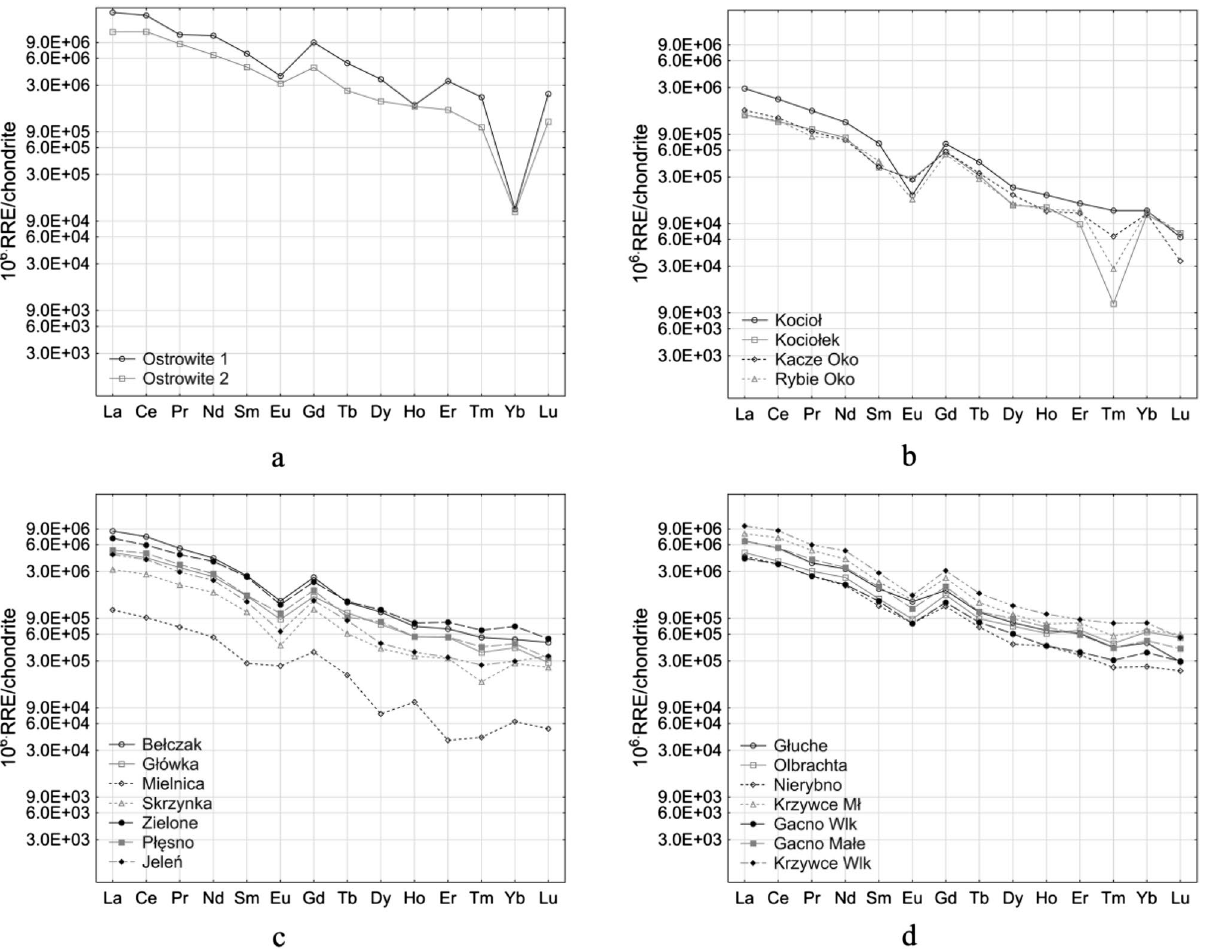
Figure 4. Standardized REE contents according to chondrite. Figure generated in Statistica 13. (https ://softw are.dell.com/produ cts/stati stica Rybie Oko lakes 0.30 and 0.42, respectively. A positive Gd anomaly was found for all lakes in the range from 1.28 to 1.71. Yb analysis showed a very strong negative anomaly for Ostrowite Lake (0.05 and 0.10) and a very strong positive anomaly for Kociołek, Kacze Oko and Rybie Oko lakes (from 2.34 to 2.76). In the case of Kociołek and Rybie Oko lakes there were negative Tm anomalies of 0.14 and 0.26, respectively. REE analysis in particular groups showed that LREE dominated over MREE and HREE in bottom sediments (Fig. 5). This is confirmed by earlier studies by Sojka et al. 32 , obtained for Lake Wadąg located in north-eastern Poland. Benabdelkader et al. 65 demonstrated that reservoirs play an important role in REE retention (LREE) and to delay the release of MREE and HREE downstream. There was slightly more MREE in the individual lakes than HREE. Only in the case of Kociołek, Kacze Oko and Rybie Oko lakes were the MREE and HREE contents at a similar level. The (La/Yb) N ratio normalized in relation to chondrite in the bottom sediments of the BTNP lakes ranged from 7.7 to 160.4. The lowest (La/Yb) N ratio was observed in Lake Olbrachta (7.7) and the highest in the western and eastern parts of Ostrowite Lake (160.4 and 103.7, respectively). In the other lakes the values (La/Yb) N ranged from 9.6 to 23.4. The obtained values were generally lower than that obtained by Sultan and Shazili 71 which was about 20.6. The CA analysis for TEs enabled the division of lakes into two main groups: TE-1 and TE-2 (Fig. 6a). Within each of the groups, two subgroups have been distinguished. The TE-1–1 subgroup includes western and eastern part of Ostrowite Lake with the highest concentrations of Li, Be, Sc, V, Cr, Co, Ni, Se, Ag, Cd, Sb, Re, Tl, Bi, Th and U. The lowest TE concentrations were found in the TE-2–2 subgroup, which included four lakes: Gacno Małe, Kocioł, Kociołek and Rybie Oko. The TE-1–2 subgroup includes seven lakes, connected by the Struga Siedmiu Jezior. The concentrations in the TE-1–2 subgroup were slightly lower than in the TE-2–1 subgroup, except for Li, Mo, U and Sc. It should be noted that the highest differences in TE concentration were found in the TE-2 group, which included 11 lakes. However, this is due to the lack of direct connection between the lakes and the various geological structure. In the case of REE concentrations in bottom sediments, lakes were divided into two groups: REE-1 and REE-2 (Fig. 6b). REE-1 includes both parts of Ostrowite Lake, in which REEs concentrations were at the highest level. However, within the REE-2 group REEs concentrations were lower, but there was a